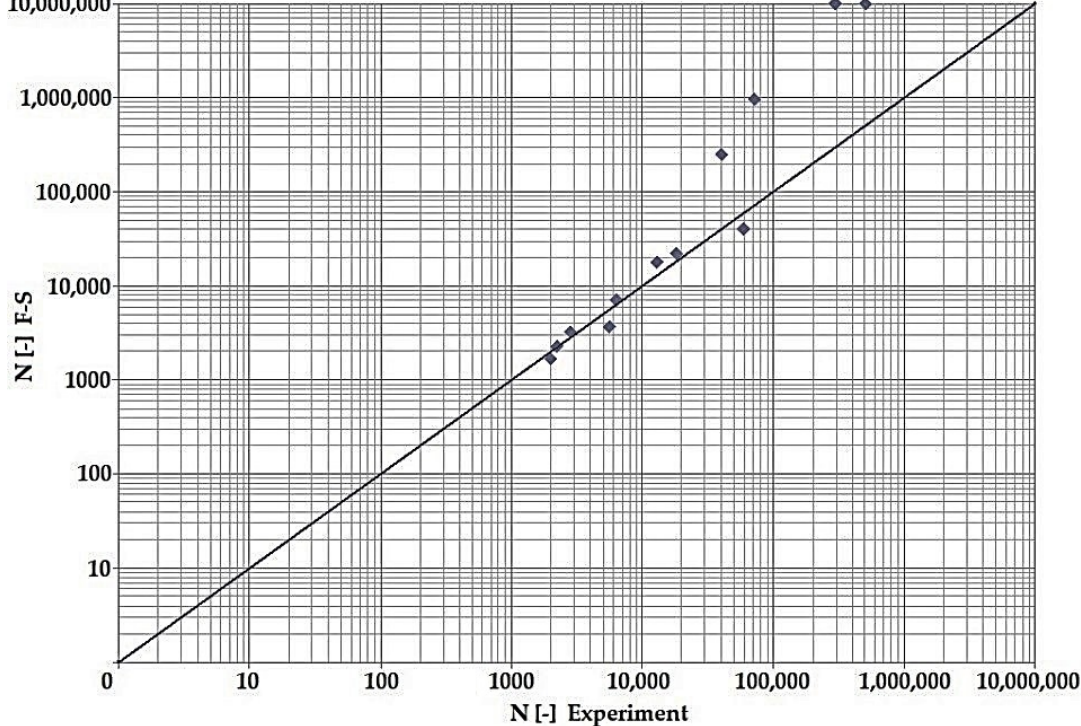
Figure 25. Dependence of theoretical and experimentally obtained number of cycles, F–S vs. experiment, phase shift 0°.